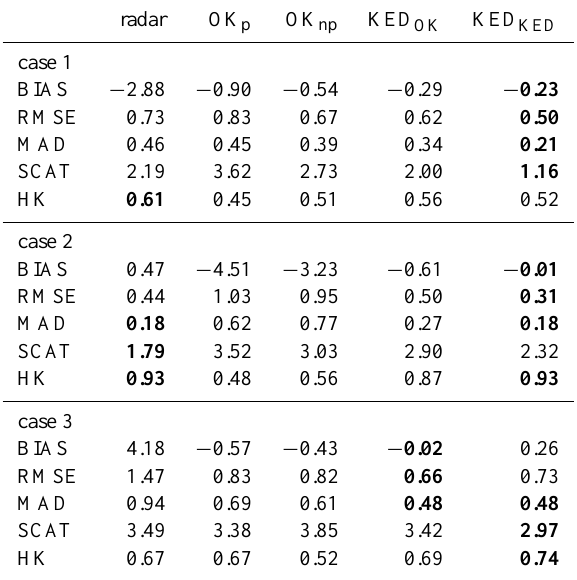
Table 2. Cross-validation skill measures for the original radar field and different merging techniques for the three test